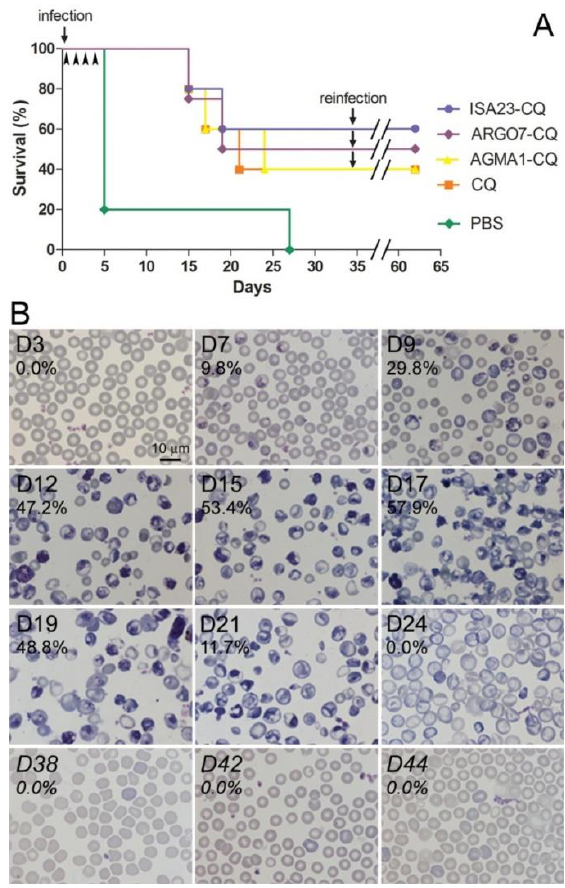
Figure 7. In vivo antimalarial activity assays. ( A ) Kaplan‒Meier plot for the in vivo assay of the effect on P. yoelii -infected mice ( n = 5 animals/sample except for ARGO7-CQ, where one of the infections was not successful) of CQ administered orally at 5 mg kg -1 day -1 , either as a free drug or polymer-conjugated. ( B ) Microscopic images of blood smears prepared on different days (D0 was the day of the first infection, and reinfection was on day 35), used to determine parasitemias in a P. yoelii -infected mouse treated with AGMA1-CQ.